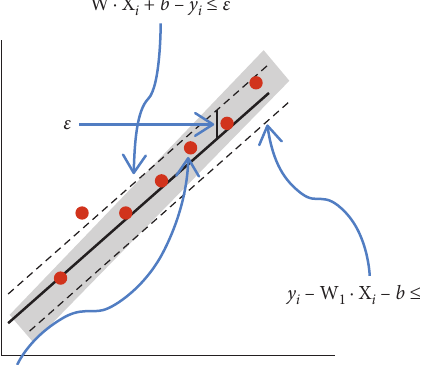
Figure 3: Hyperplane of SVM